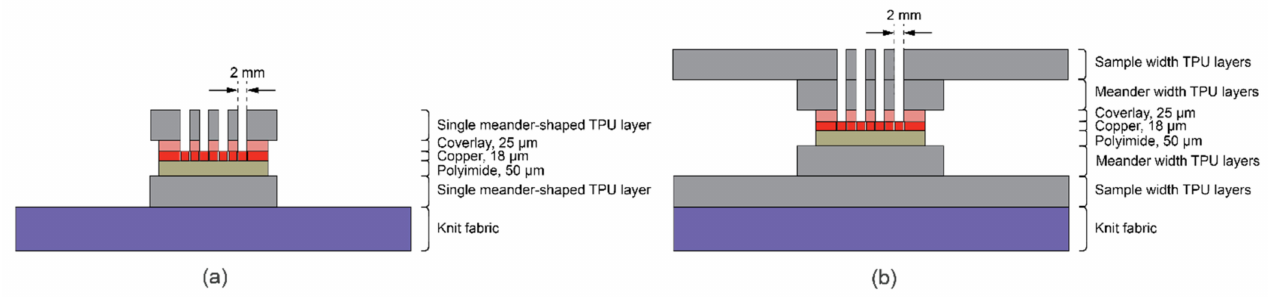
Figure 11. Layering system of samples. ( a ) V1 and V3 layering systems in the current tests. ( b ) Most successful TPU layering system in the previous work, reproduced with permission